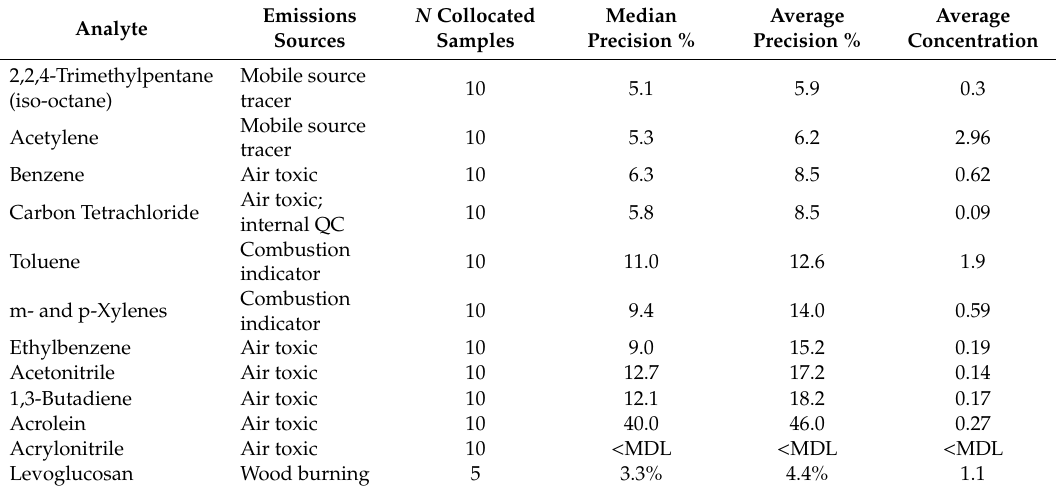
Table 2. Collocated HAPs and levoglucosan sample results ( µ g / m 3